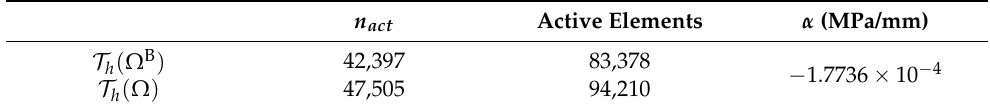
Table 5. Background mesh T h ( Ω B ) and conformal mesh T h ( Ω ) parameters.